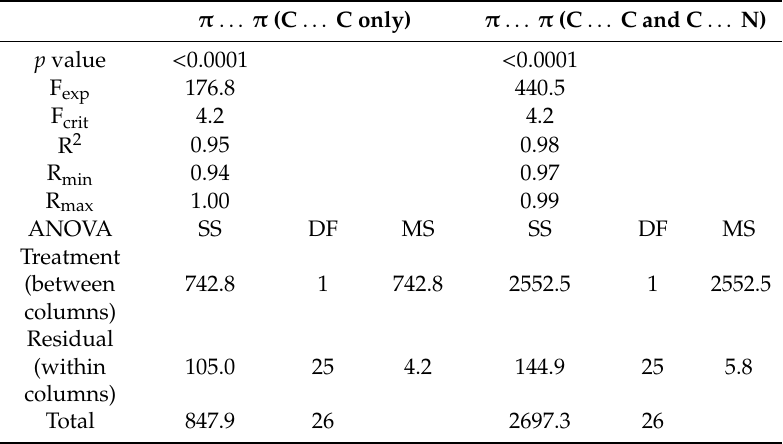
Table 3. One-way analysis of variance (ANOVA) for π ... π interactions. π ... π (C ... C